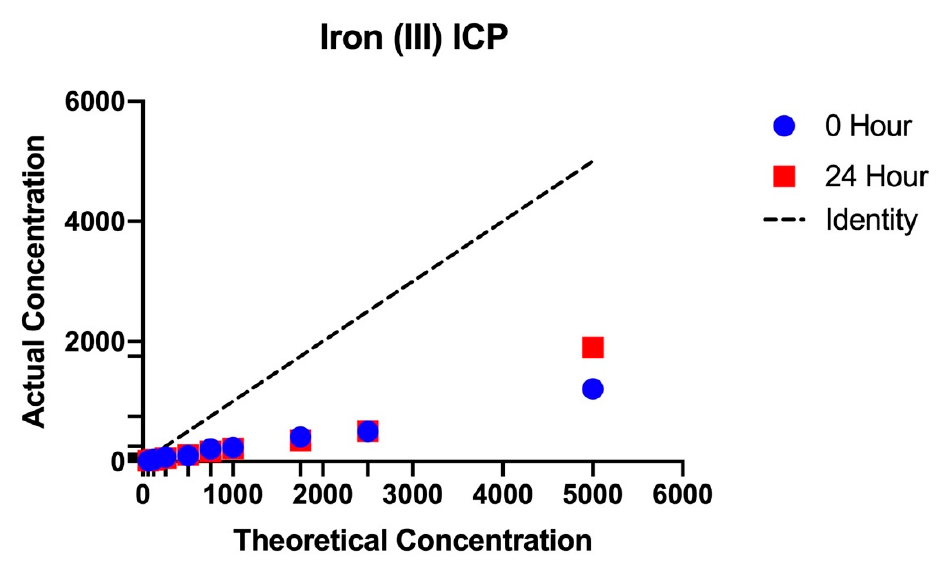
Figure A2. The amount of ionic iron (III) at 0 and 24 h resulting from iron (III) in DMB medium.